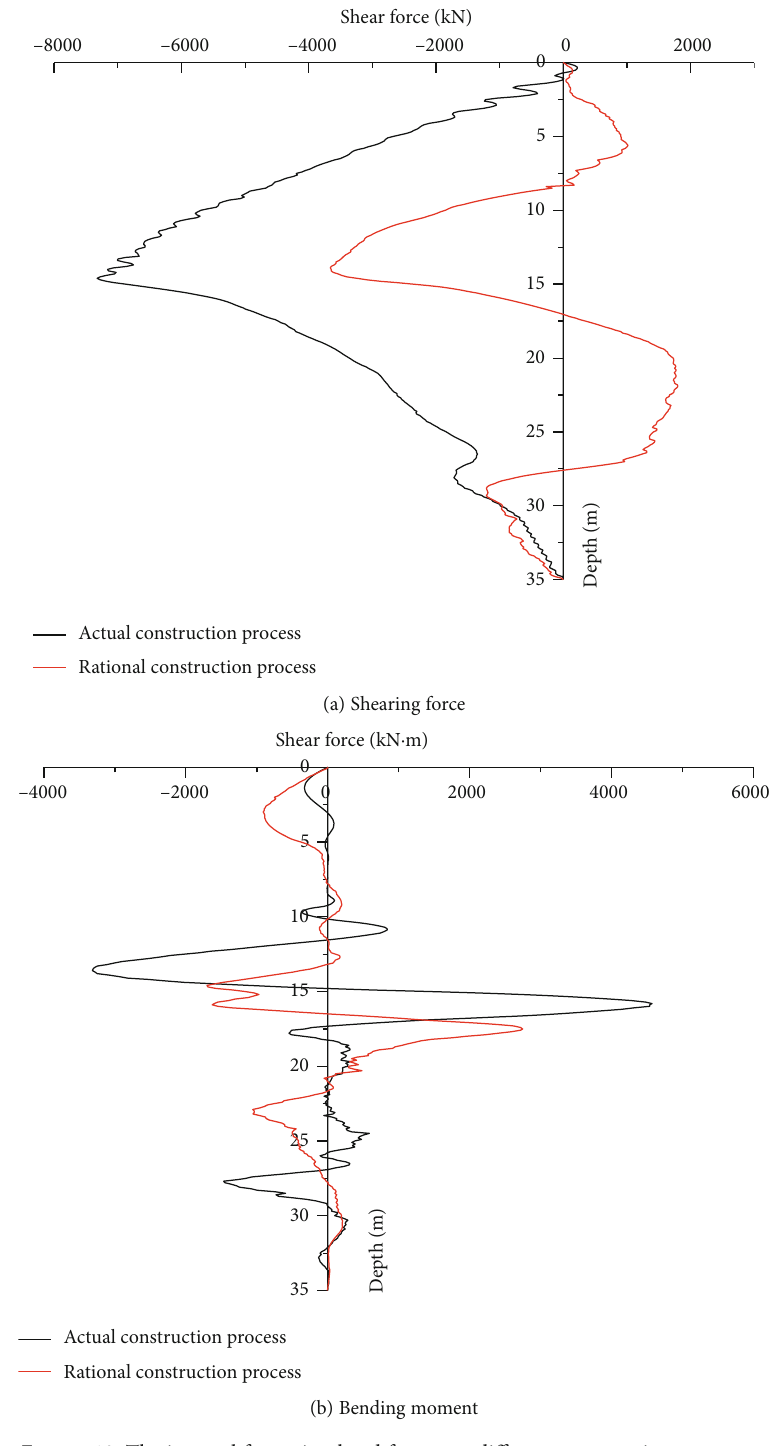
Figure 13: The internal force simulated from two di ff erent construction